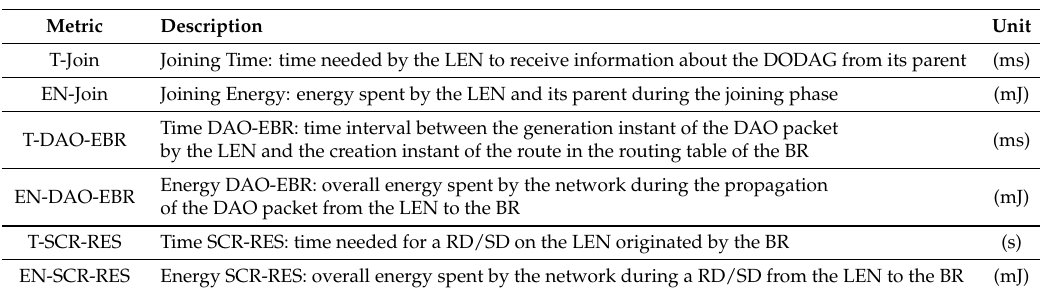
Table 1. Performance